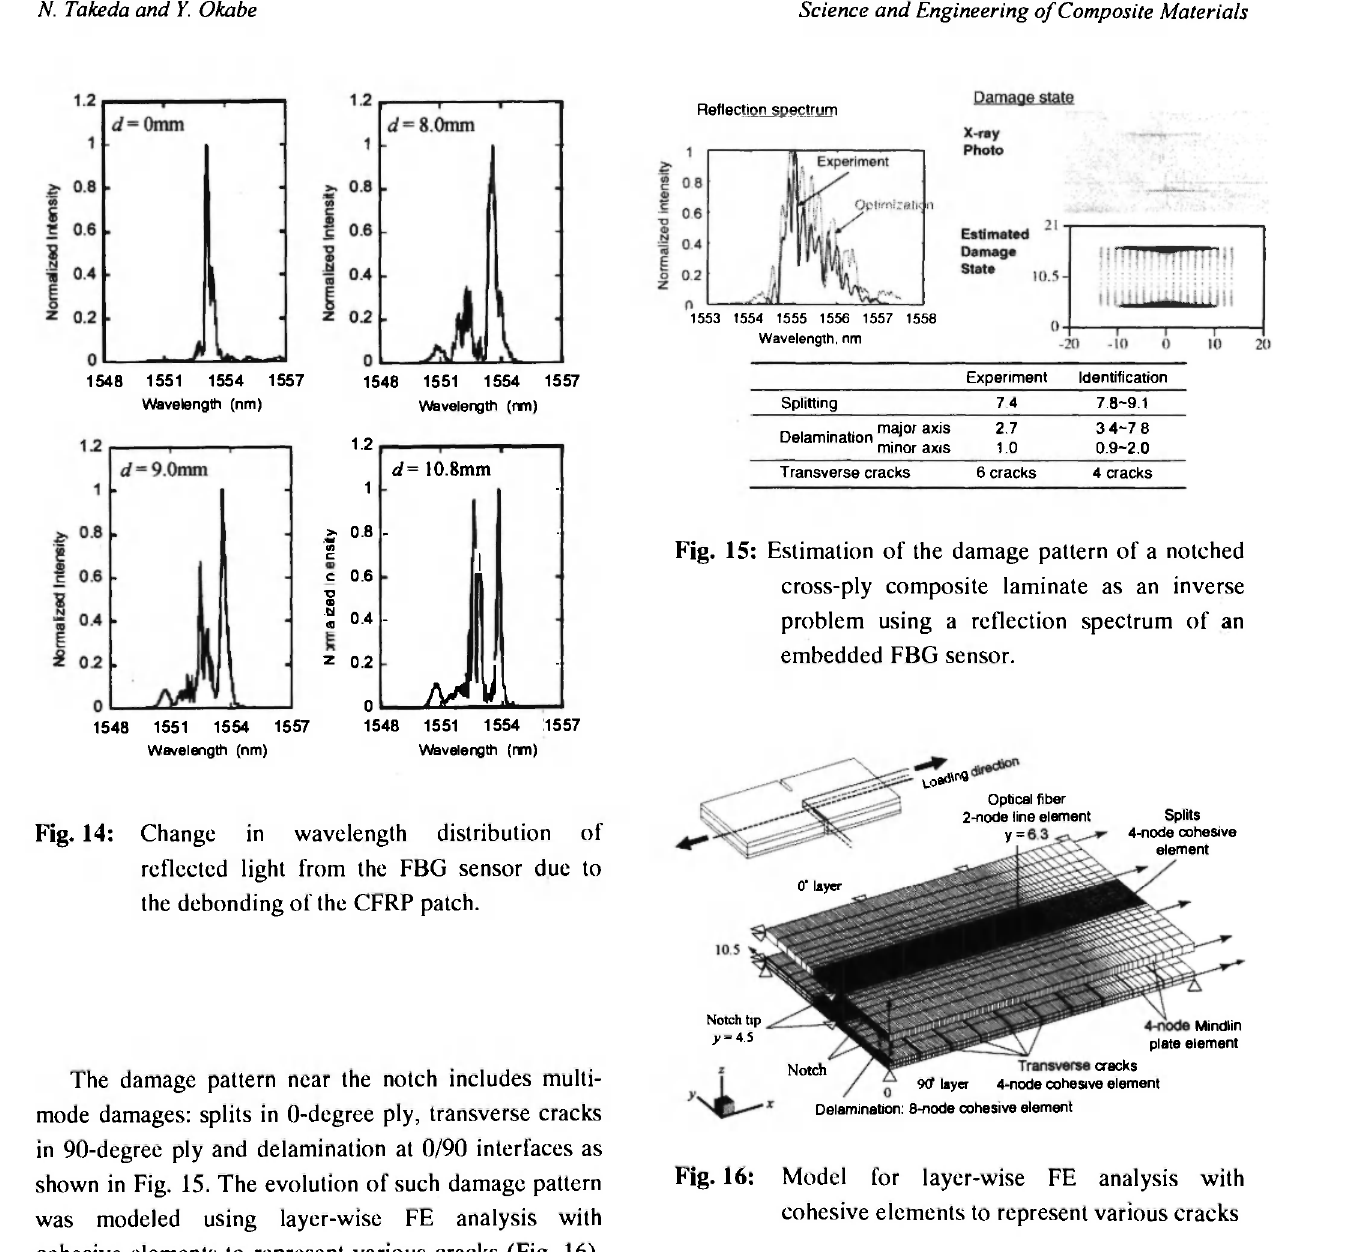
Fig. 16: Model for layer-wise FE analysis with cohesive elements to represent various cracks